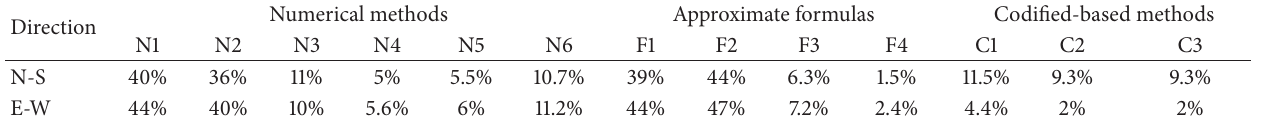
Table 4: Percentage of the errors between numerical, analytical, and codified methods with experimental tests. Direction